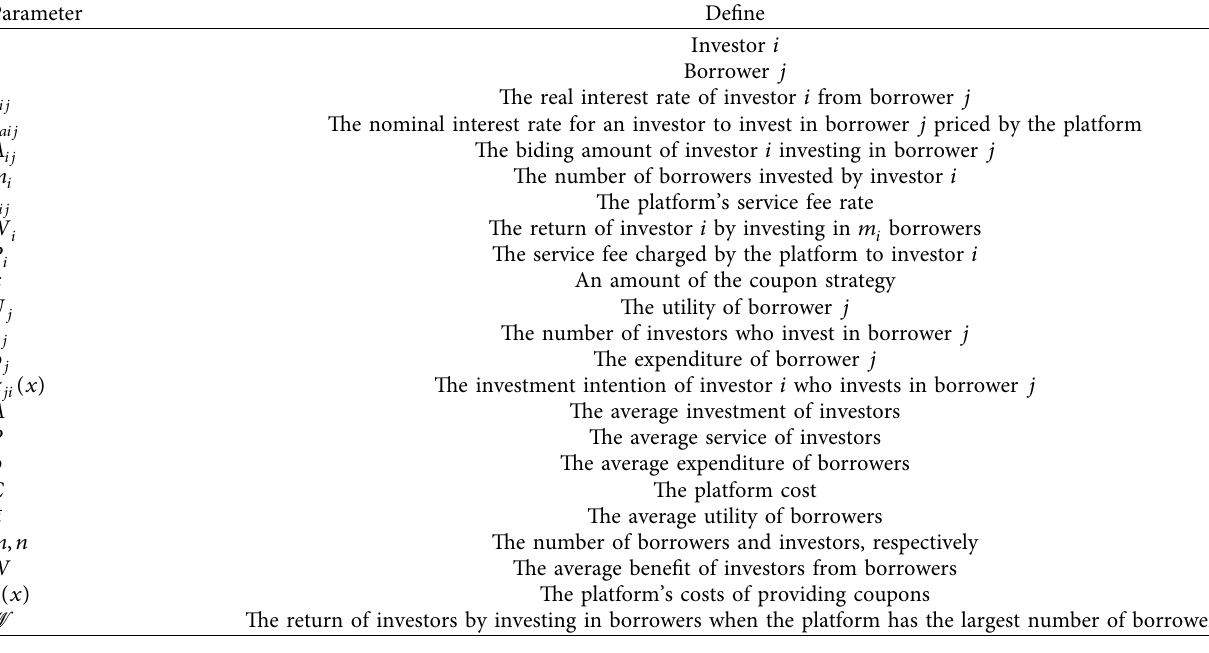
Table 1: Parameter